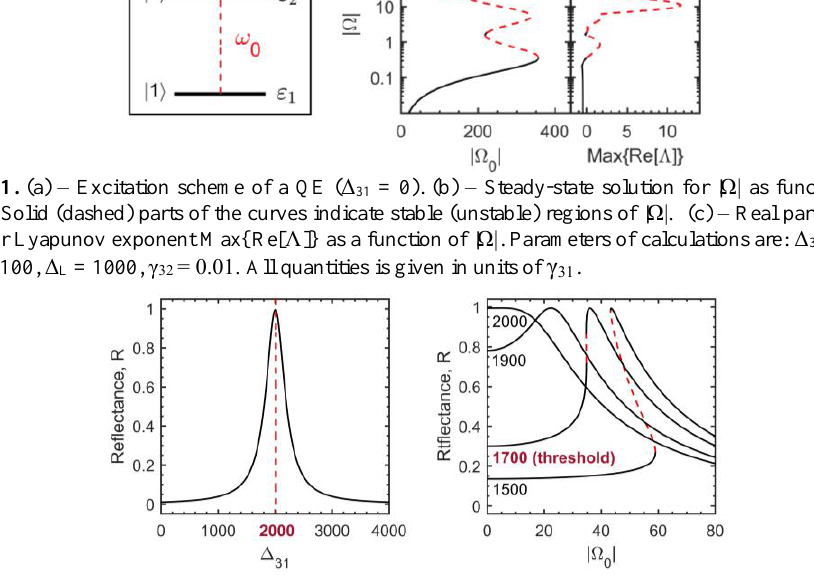
Fig. 2. Left panel – the linear reflection coefficient R as a function of the detuning Δ 31 . Right panel – the field dependence of R computed for a set of detunings Δ 31 shown in the plot. The value Δ 31 = 1700 is the threshold for bistability to occur. The rest of parameters are the same as in Fig. 1. Fig. 2 shows the detuning and field dependence of the reflectance R = | Ω refl / Ω 0 | 2 (left